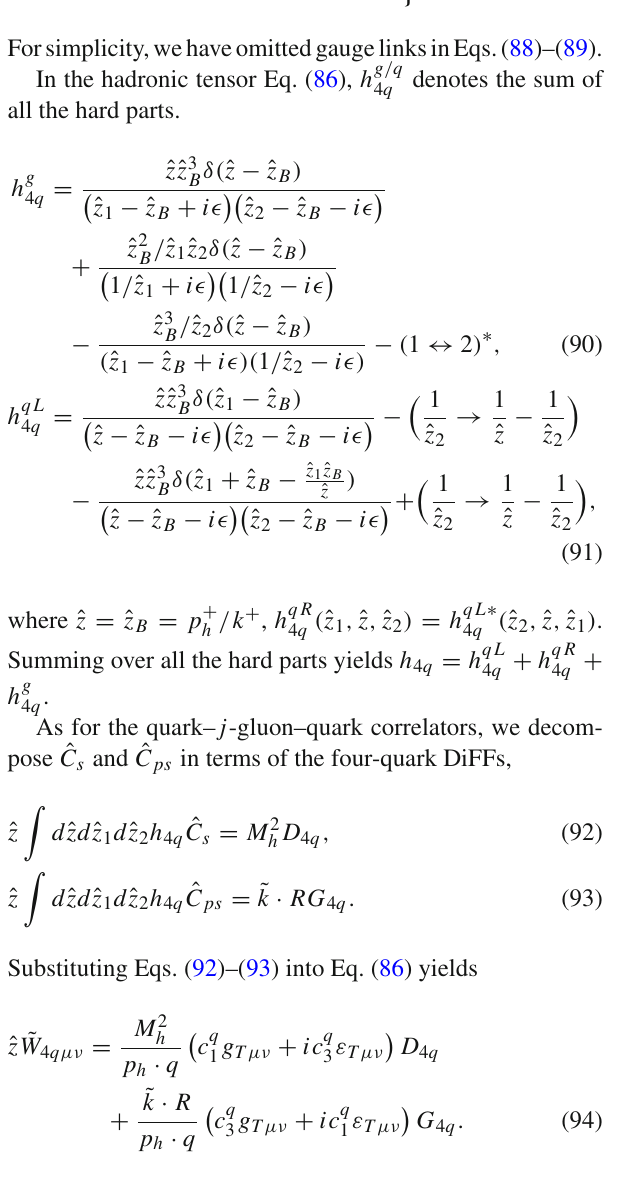
; in ( d ) we have both interchanges of k 1 with k (cid:4) 2